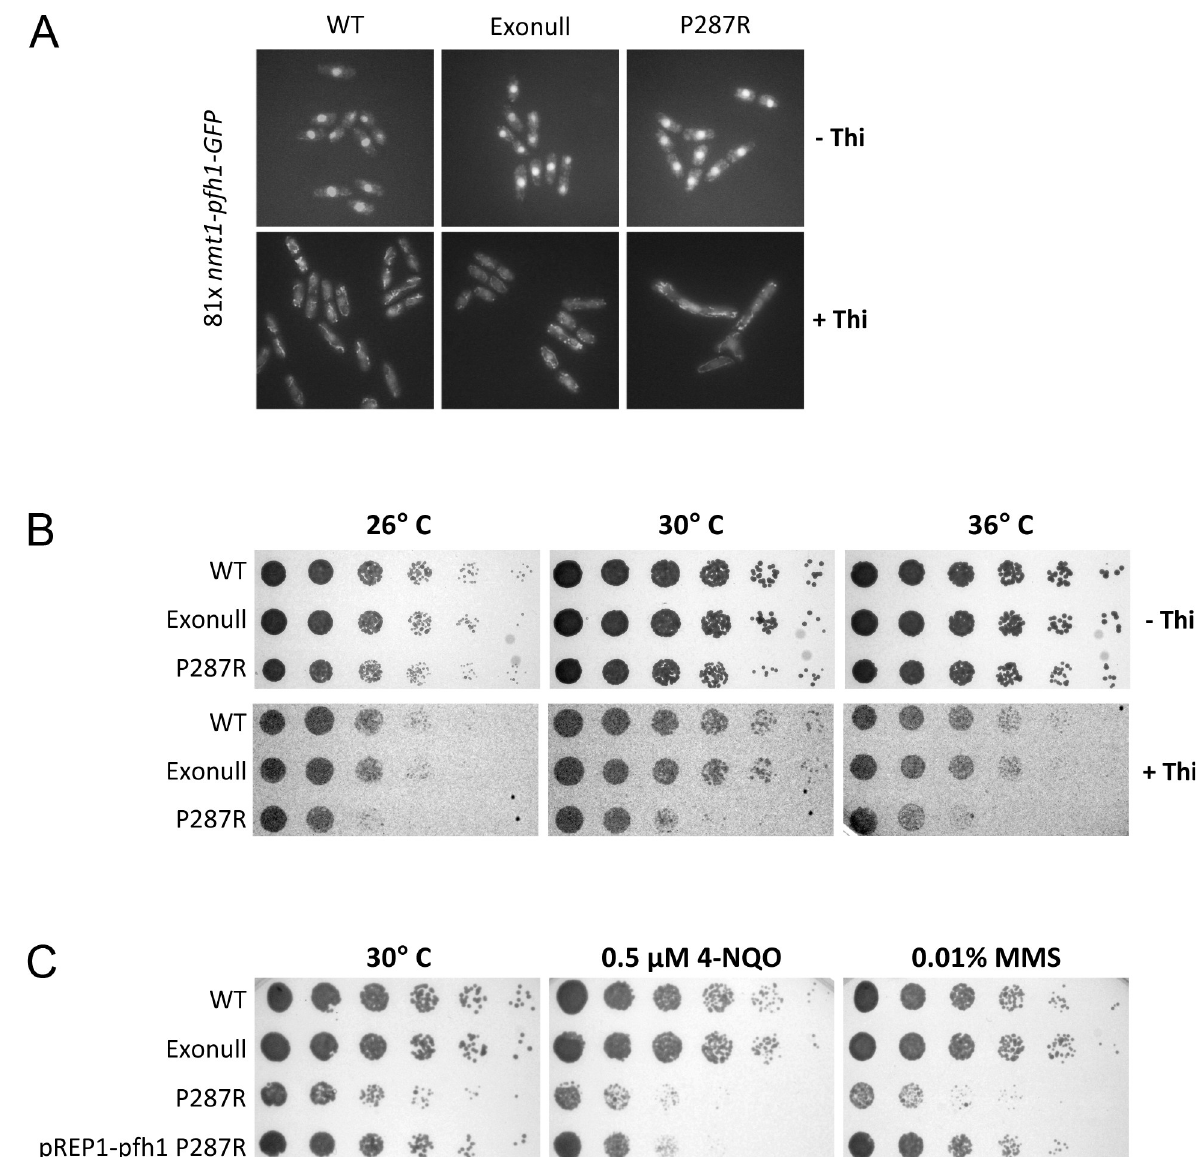
Fig 6. Genetic interaction between pol2-P287R and pfh1 . (A) nmt1-pfh1 cells were cultured to midlog phase in minimum medium containing 15 μ M thiamine, or no thiamine and imaged live. Representative pictures under unrepressed (-Thi) or pfh1 repression (+Thi) are shown. (B) 1:5 serial dilutions of the indicated strains with thiamine-regulatable pfh1 ( nmt1-81Xpfh1-GFP ) were spotted onto minimum medium plus or minus thiamine and incubated 3 days at 26˚, 30˚ and 36˚C. (C) As (B) except cells were spotted onto minimal medium plates without thiamine containing 0.5 μ M 4-NQO, 0.01% MMS or no